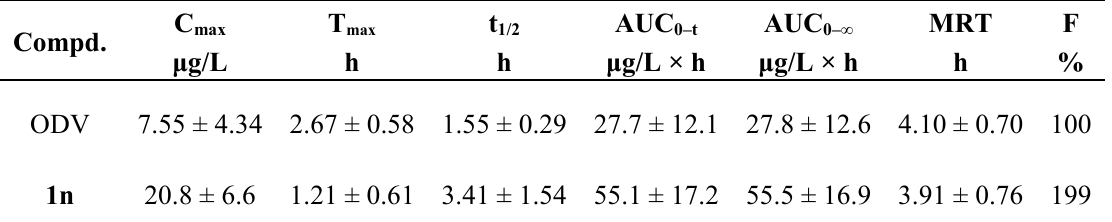
Table 2. PK parameters of ODV in a cross-over study involving oral administration of compound 1n and ODV at a dose of 0.007 mmol/kg to a group of beagle dogs (data are means ± SD, n =